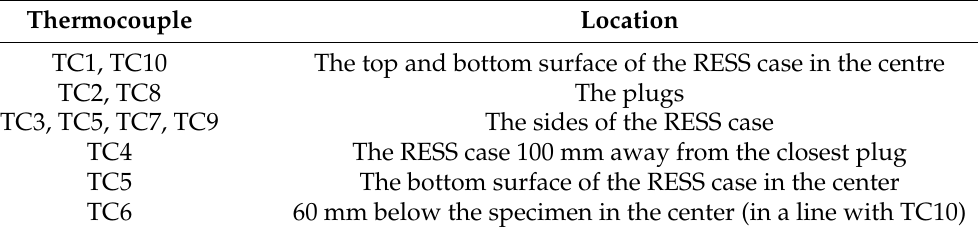
Figure 2. Thermocouple positioning scheme. (Top view of the tested element— left ); (Side view of the tested element— right ). Table 3. Thermocouples locations on the